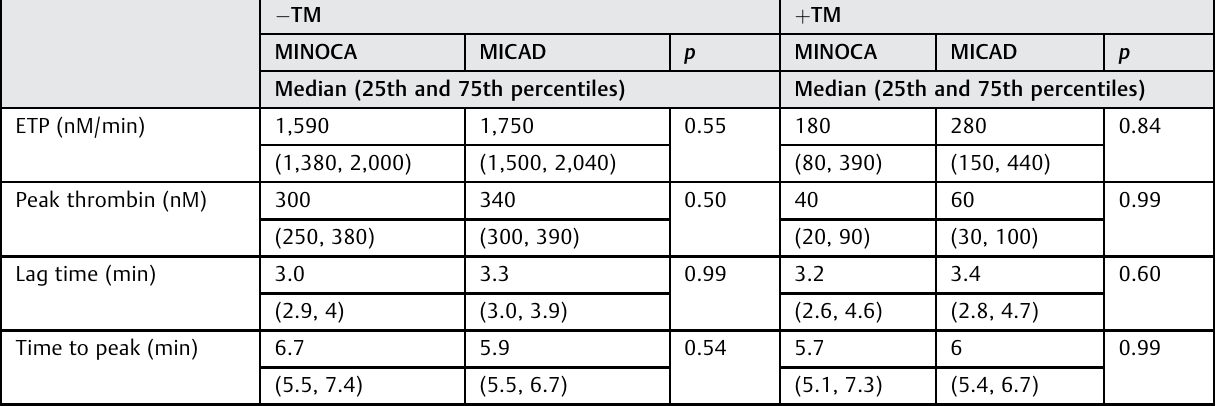
Table 2 Thrombin generation test parameters